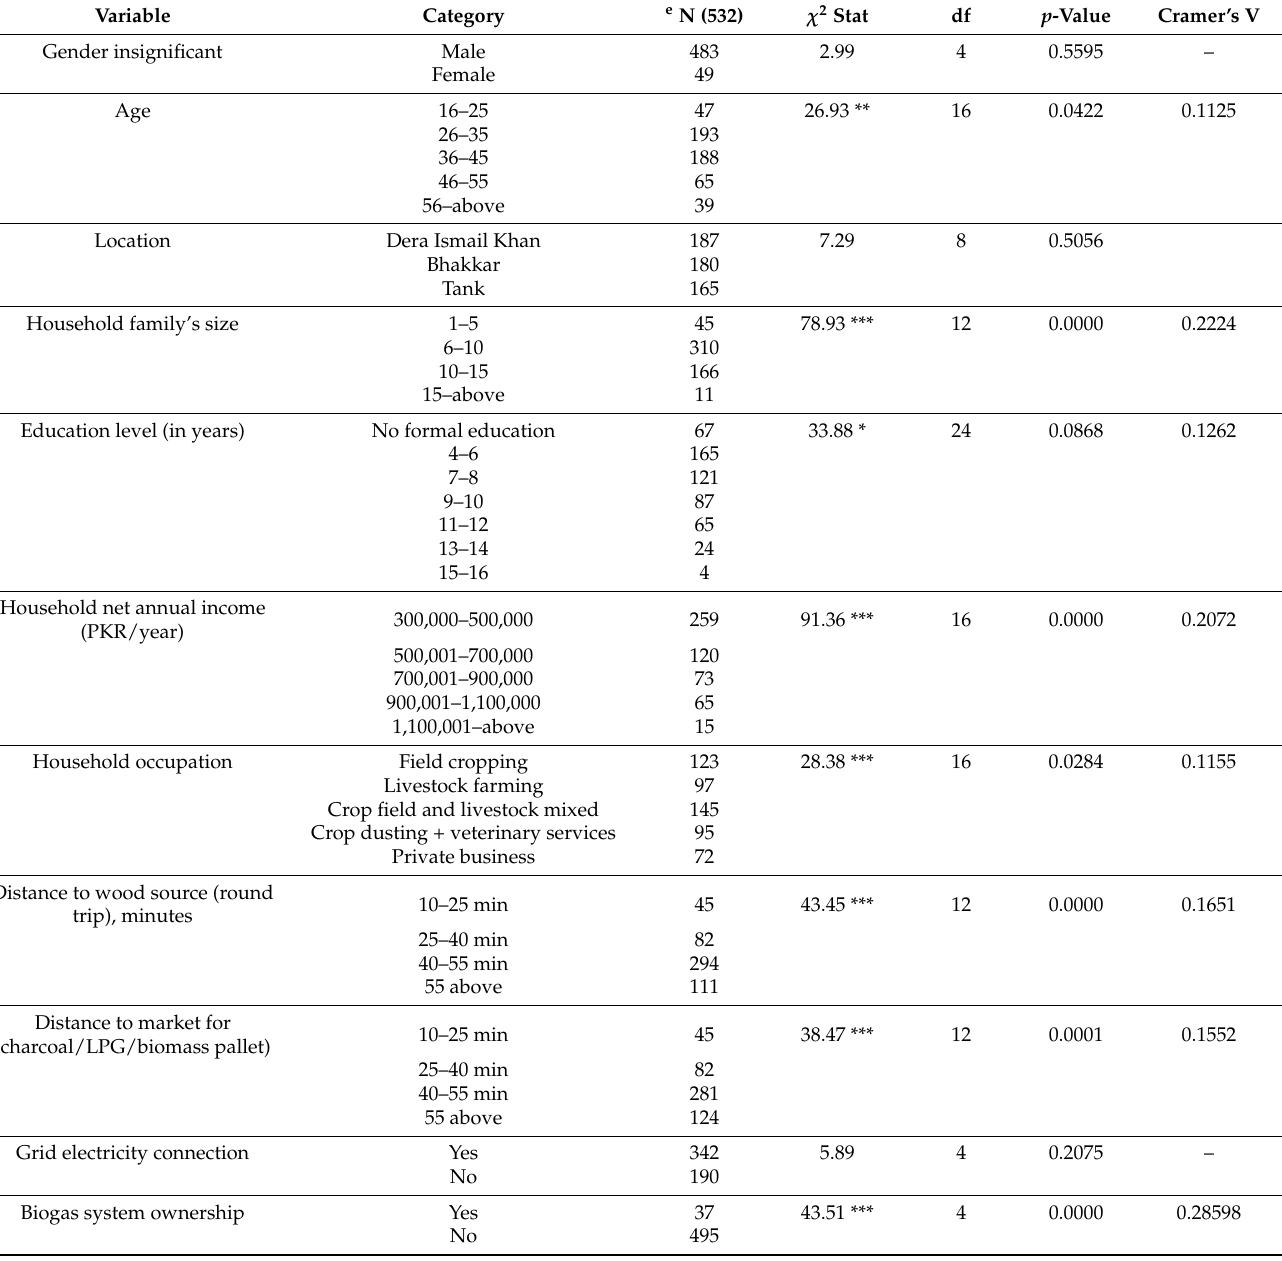
Table 4. Pearson’s Chi square ( χ 2 ) test of association between household characteristics and primary cooking fuel